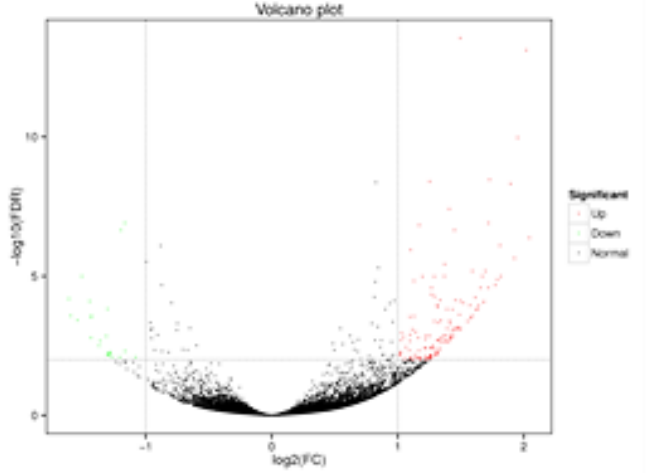
Figure 8. Volcano plot of differentially expressed gene distribution.